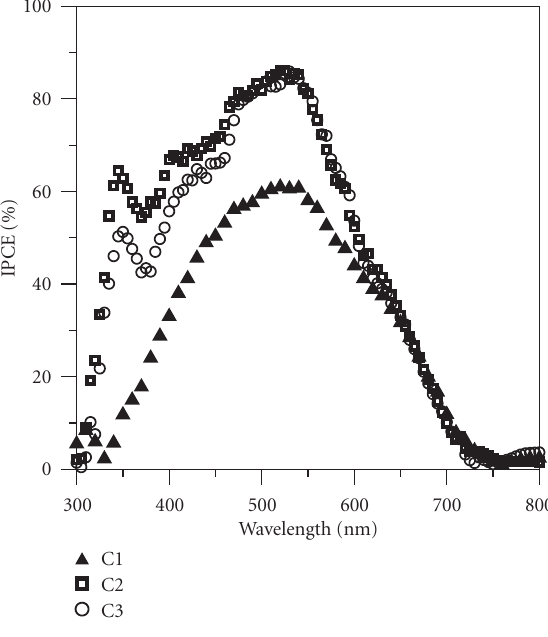
Figure 5: IPCE spectra for the DSCs fabricated with di ff erent counter